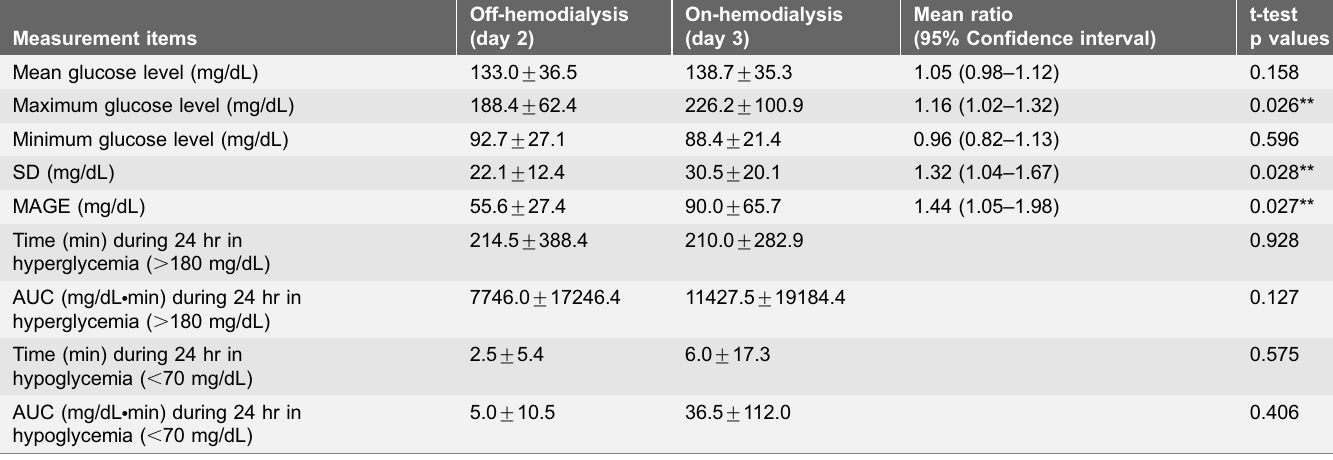
Table 4. Plasma glucose profiles after subcutaneous administration of liraglutide in diabetic patients with ESRD on-hemodialysis and off-hemodialysis. Measurement